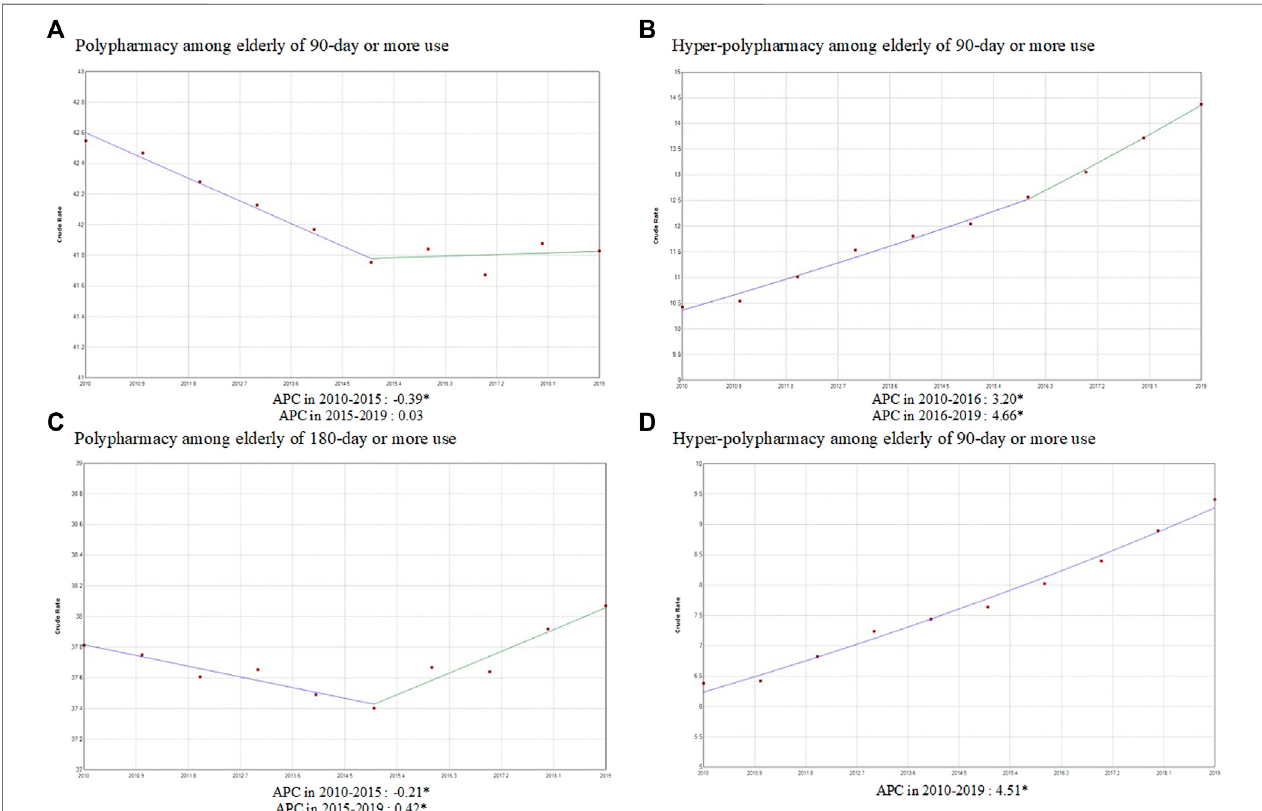
FIGURE 1 | The trend of the prevalence of polypharmacy and hyper-polypharmacy among the elderly prescribed ≥ 90 days and ≥ 180 days from 2010 to 2019. APC: Annual percent change, CI, con fi dence interval.